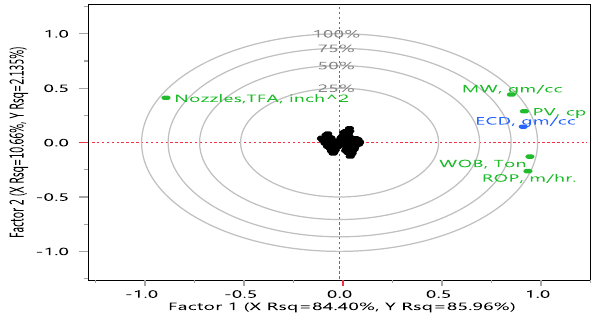
Fig. 21 Percent of variation explained by each factor for Y -variable (ECD model)